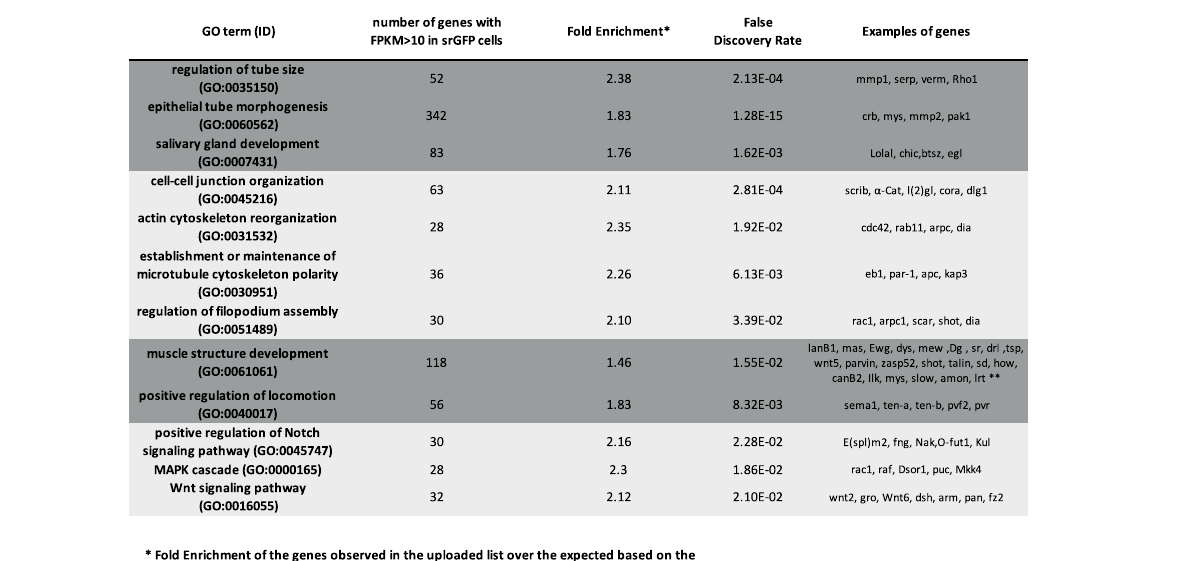
Frontiers in Cell and Developmental Biology |